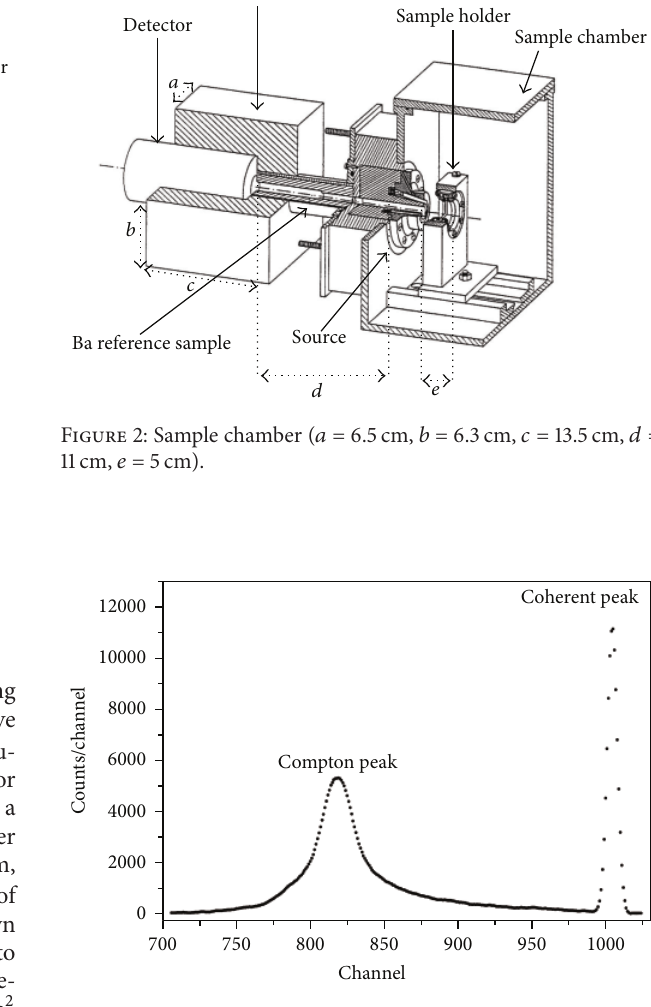
Figure 3: Typical observed spectra at 167 ∘ from La 2 O 3 target when irradiated by 59.54 keV incident photon energy.